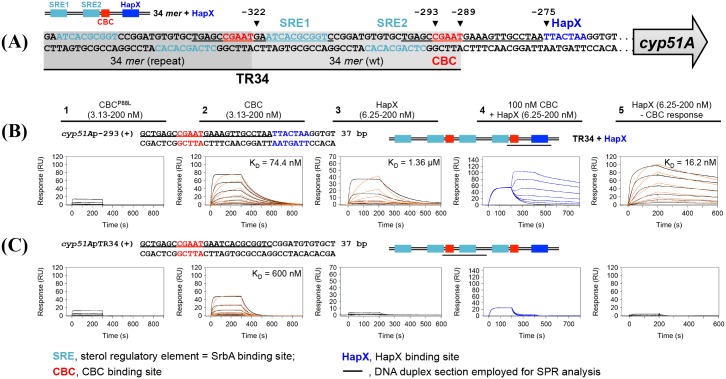
The CBC binds to a CGAAT motif within the 34 mer of the cyp51A promoter, which is facilitated HapX. This interaction is perturbed by the HapEP88L modification.(A) Schematic depiction of the cyp51A TR34 promoter region. (B) & (C) To further analyse the in vivo binding site for the CBC in vitro, real-time SPR analysis was employed. Binding of the mutated CBCP88L (HapB/HapC/HapEP88L) to DNA (panel 1), wt CBC (HapB/HapC/HapE) to DNA (panel 2), HapX to DNA (panel 3) and HapX to preformed CBC/DNA complexes (panel 4) was monitored. The SPR sensorgrams are shown from sensor-immobilised 37 base pair DNA dduplexes containing the CGAAT motifs of the respective wt promoter section (cyp51A-293) as well as the TR34 tandem repeat variant (cyp51A-TR34). Underlined nucleotides are covered upon CBC binding according to the CBC/DNA binary complex crystal structure [23]. Binding responses of the indicated CBC or HapX concentrations injected in duplicate (black lines) are shown overlaid with the best fit derived from a 1:1 interaction model including a mass transport term (red lines). Sensorgrams in panel 5 depict the association/dissociation responses of HapX on preformed CBC/DNA and were generated by CBC response (co-injection of buffer instead of HapX) subtraction from HapX co-injection responses. Dissociation constants (KD) are given inside the graphs.